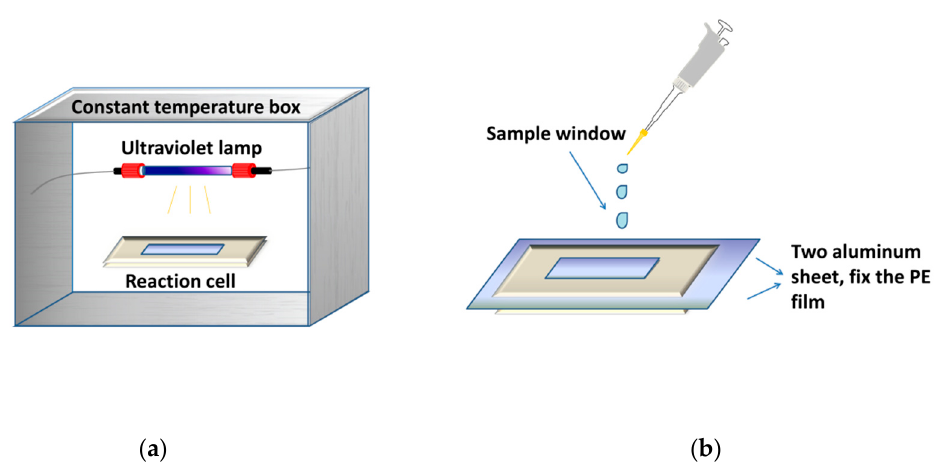
Figure 6. The gas-solid photoreactor used to investigate photo-oxidation process. ( a ) photo-oxidation equipment; ( b ) structure of reaction cell.